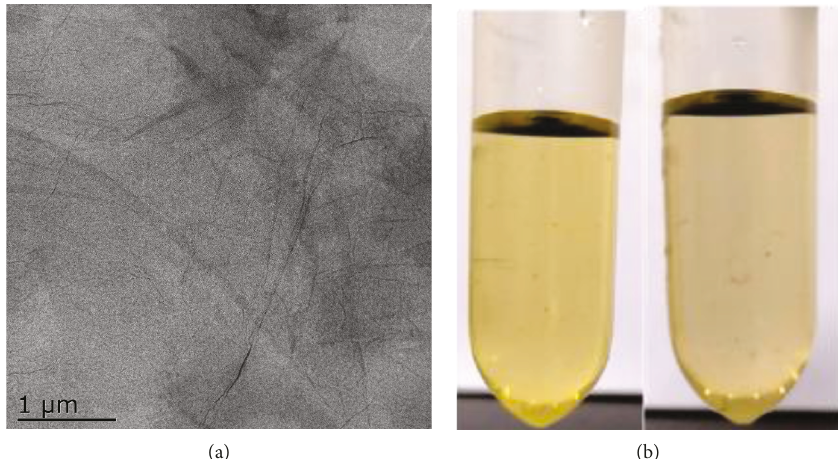
Figure 5: (a) TEM image of GO-FA-CD; (b) nanocarrier solution after being prepared (left) and after being prepared for one week (right). 0.000.030.060.090.12